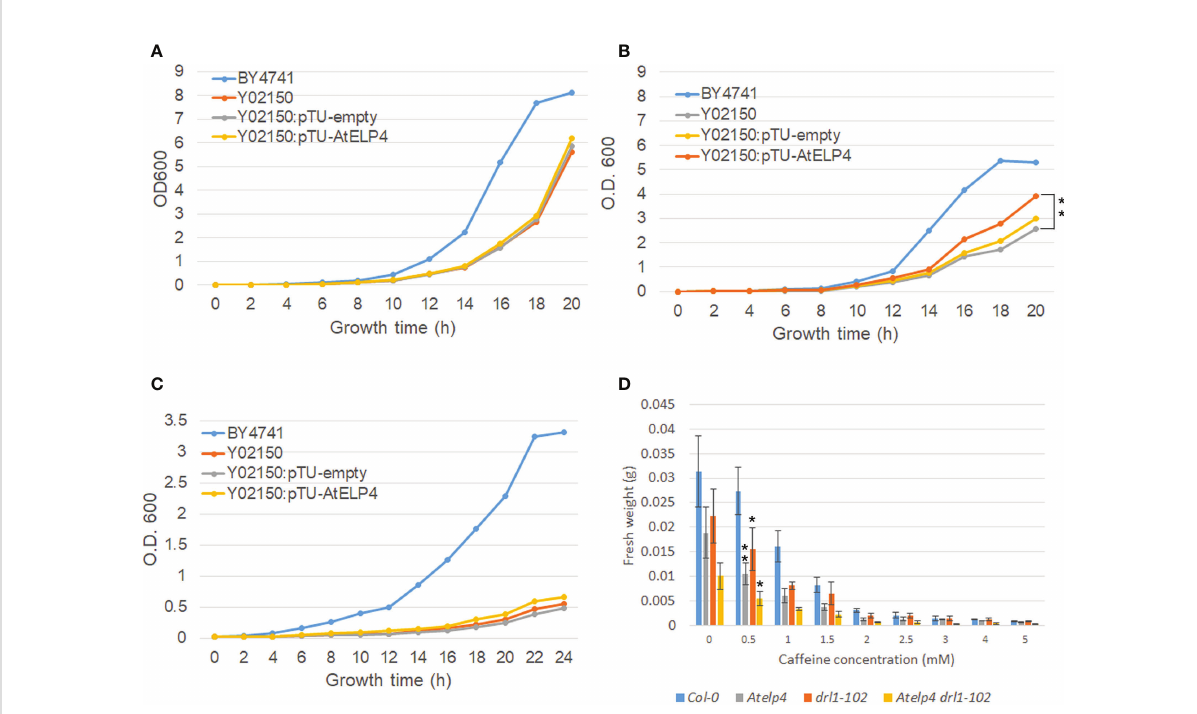
FIGURE 5 Complementation test of yeast elp4 D mutant and caffeine sensitivity of Arabidopsis Atelp4 and drl1-102 single and double mutants. (A – C) Complementation of yeast elp4 D mutant, Y02150 by Arabidopsis ELP4 expression in thermosensitivity and caffeine sensitivity. Wild-type BY4741, elp4 D mutant Y02150, and the empty vector pTU1 or ELP4 -driven pTU1 introduced Y02150 transgenic lines were grown in YPD media. For test of thermosensitivity, yeast lines were grown at (A) 30°C and (B) 38°C. Asterisks indicate signi fi cant differences compared to Y02150 at 20 h using a Student ’ s t -test (**, p-value <0.01). (C) For test of caffeine sensitivity, yeast lines were grown in YPD media containing 7.5 mM of caffeine. Yeast growth was determined by measuring optical densities at 2-h intervals over a period of 20 h using a spectrophotometer at 600 nm. (D) Caffeine sensitivity of Arabidopsis wild type, and Atelp4 , drl1-102 , and Atelp4 drl1-102 mutants. Plants were grown in MS media containing caffeine concentration in the range of 0 to 5 mM for 21 DAS, and then fresh weight of plants was measured. Ten individuals in each plant were collected, and data are shown as the means with SEs. Asterisks in panels B and D indicate signi fi cant differences compared to no treatment of each plant group using a Student ’ s t -test (*p-value <0.05; **p-value